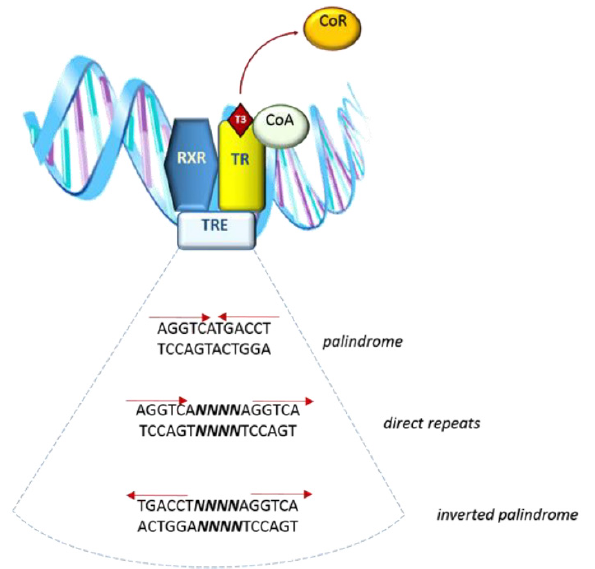
Figure 1. Simplified representation of interaction of the complex T3–TR dimer-CoActivator and TRE sequence in the target gene.